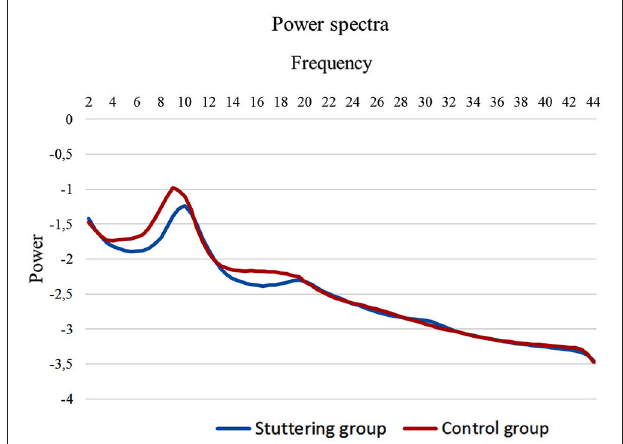
FIGURE 1 | EEG power spectra . EEG power spectra in stuttering patients (blue line) and fluently speaking controls (red line) averaged over all